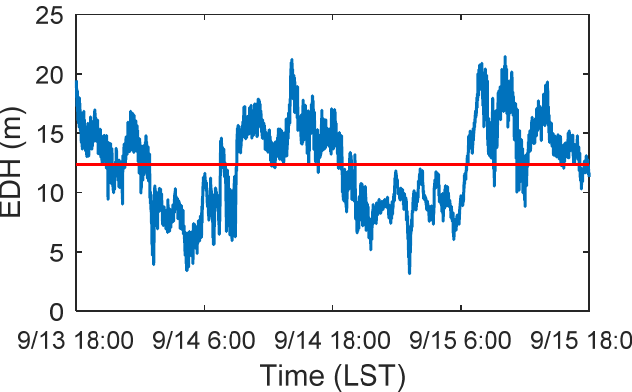
Figure 3. Daily variation of the evaporation duct height (red line indicates the average EDH).